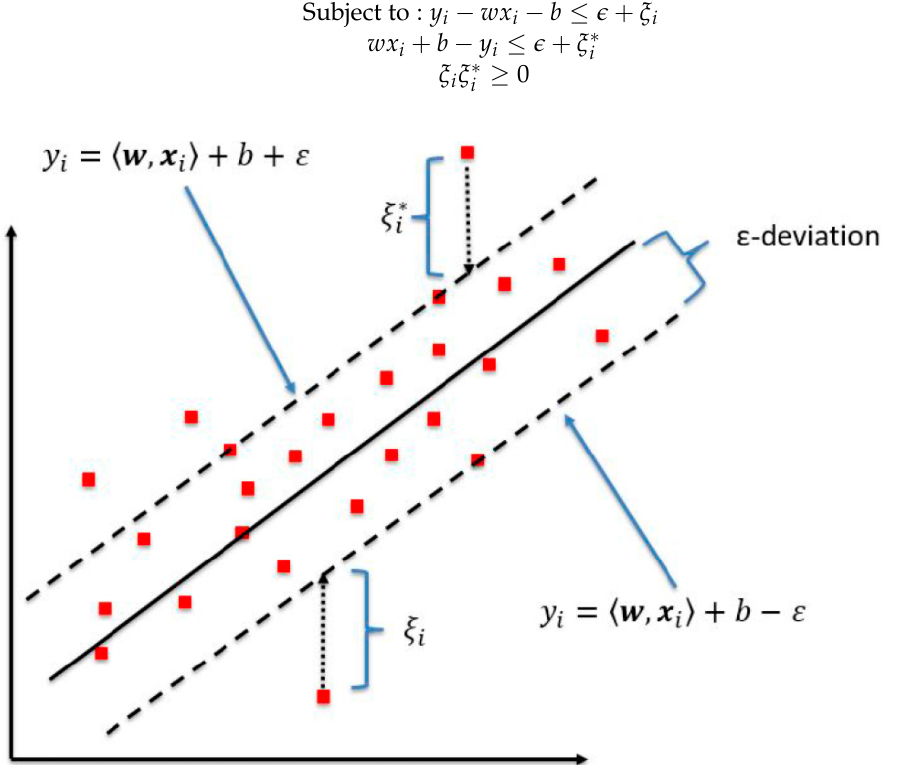
Figure 4. Concept of Support Vector Machine [34]. (3) eXtreme Gradient